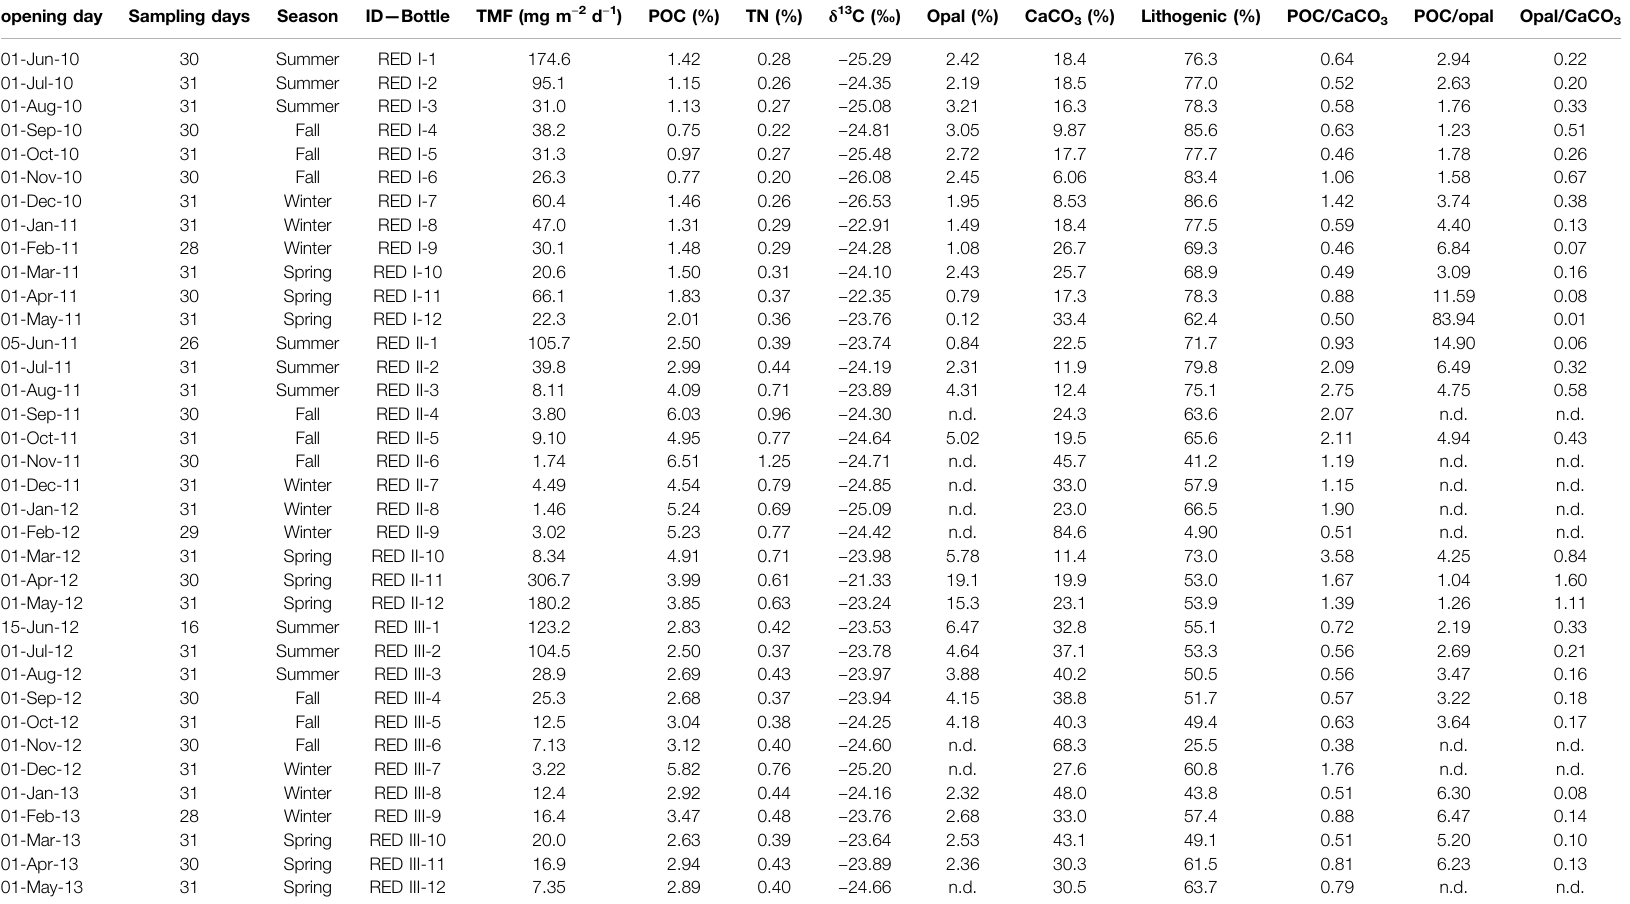
TABLE 1 | Total mass fl uxes (TMF) and bulk composition of sinking particles collected at 4,285 m in the Ierapetra Basin (n.d.: no data). opening day Sampling